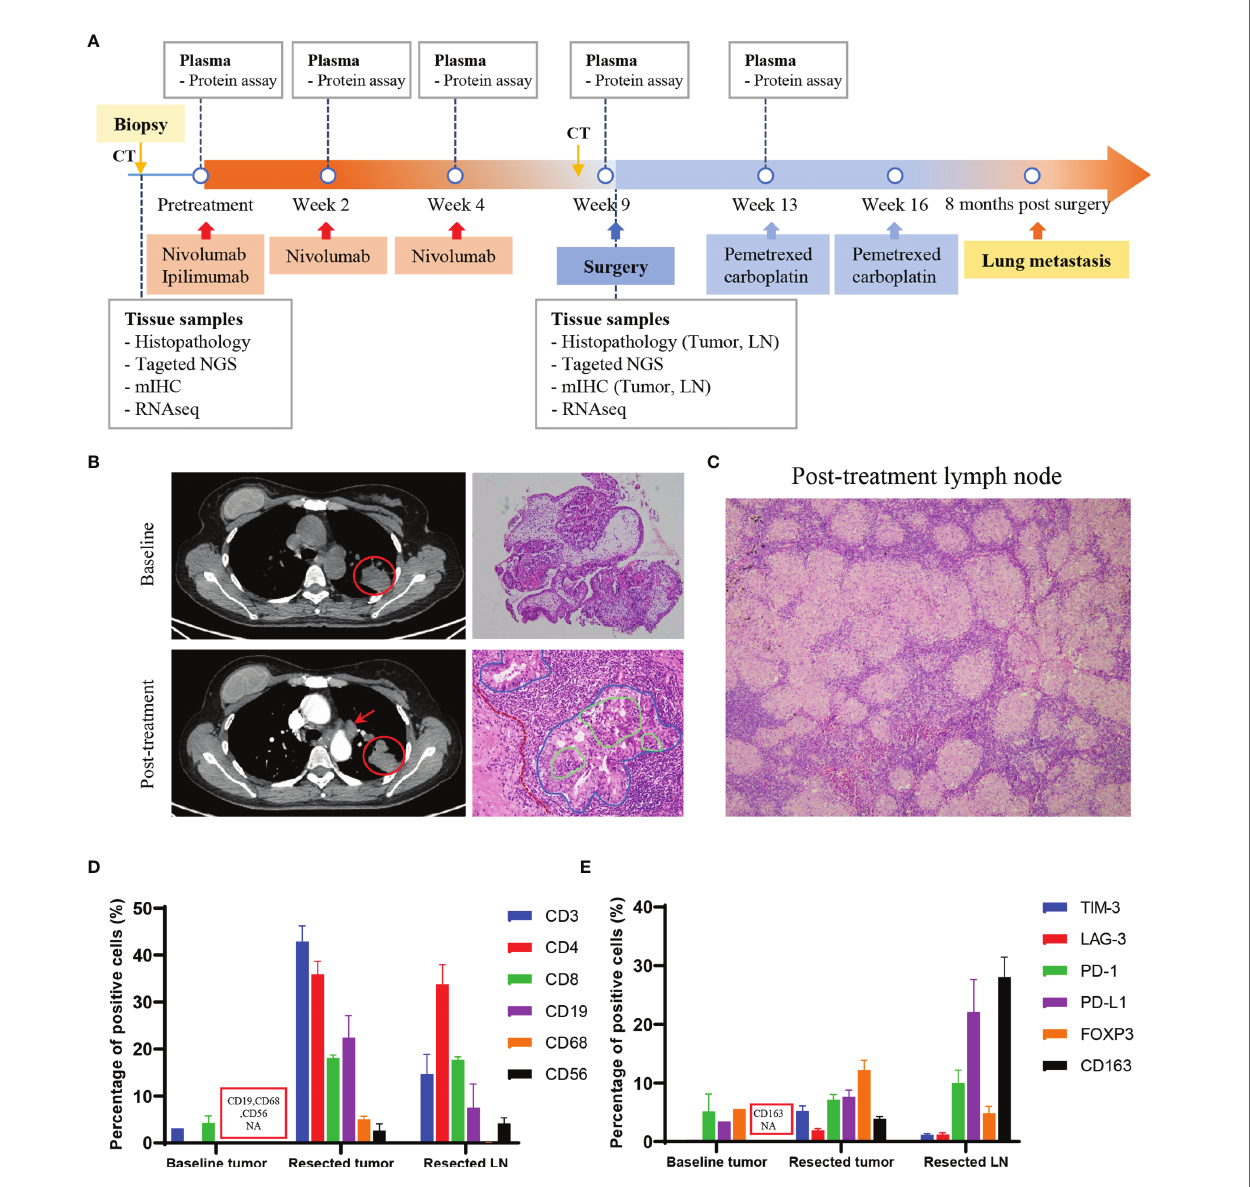
FIGURE 1 | Treatment course of the patient with lung adenocarcinoma. (A) Time line of clinical events, along with the time points of sample collection and analyses. (B) CT images showed the primary tumor (red circle) and lymph node (red arrow), and the pathological images of the tumor pre- and post-immunotherapy treatment. Red dotted line: fi brosis in the tumor stroma; blue solid line: cancer nest; green solid line: lymphocytes in fi ltrating into the cancer nest. Magni fi cation: 100×, 200×. (C) Pathological image of the post-treatment lymph node showed non-caseating granulomas. Magni fi cation: 100×. (D, E) Quantitative results of immune cell markers (D) and regulatory or inhibitory markers (E) in the baseline biopsy tumor (pre-treatment), resected tumor and resected lymph node (post-treatment) by mIHC assay. For bar graph: error bar represents SEM . CT, computed tomography; NGS, next-generation sequencing; mIHC, multiplex immunochemistry; LN, lymph node; NA, not